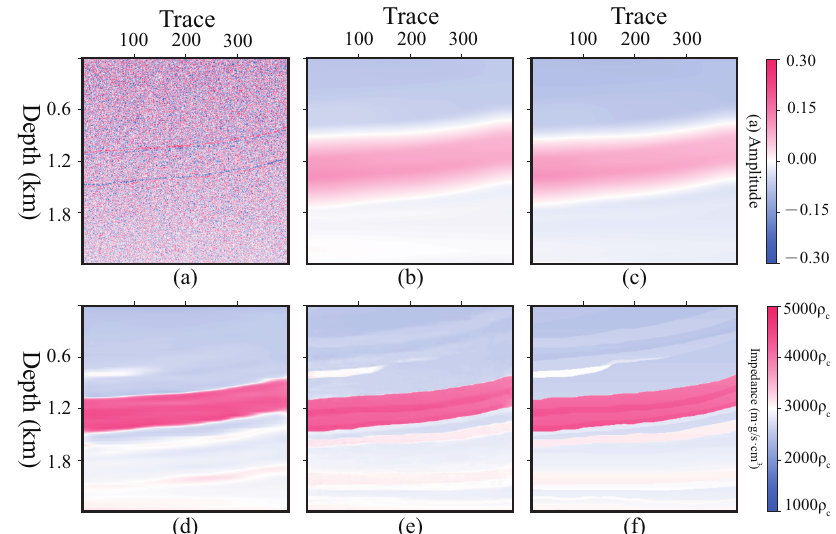
Figure 7. Predicted profiles at different epochs. ( a ) M , channel 1 of input data, ( b ) B , channel 2 of input data, ( c ) predicted profile ˆZ at 10 epoch, ( d ) predicted profile ˆZ at 50 epoch, ( e ) predicted profile ˆZ at 300 epoch, ( f ) label profile Z .